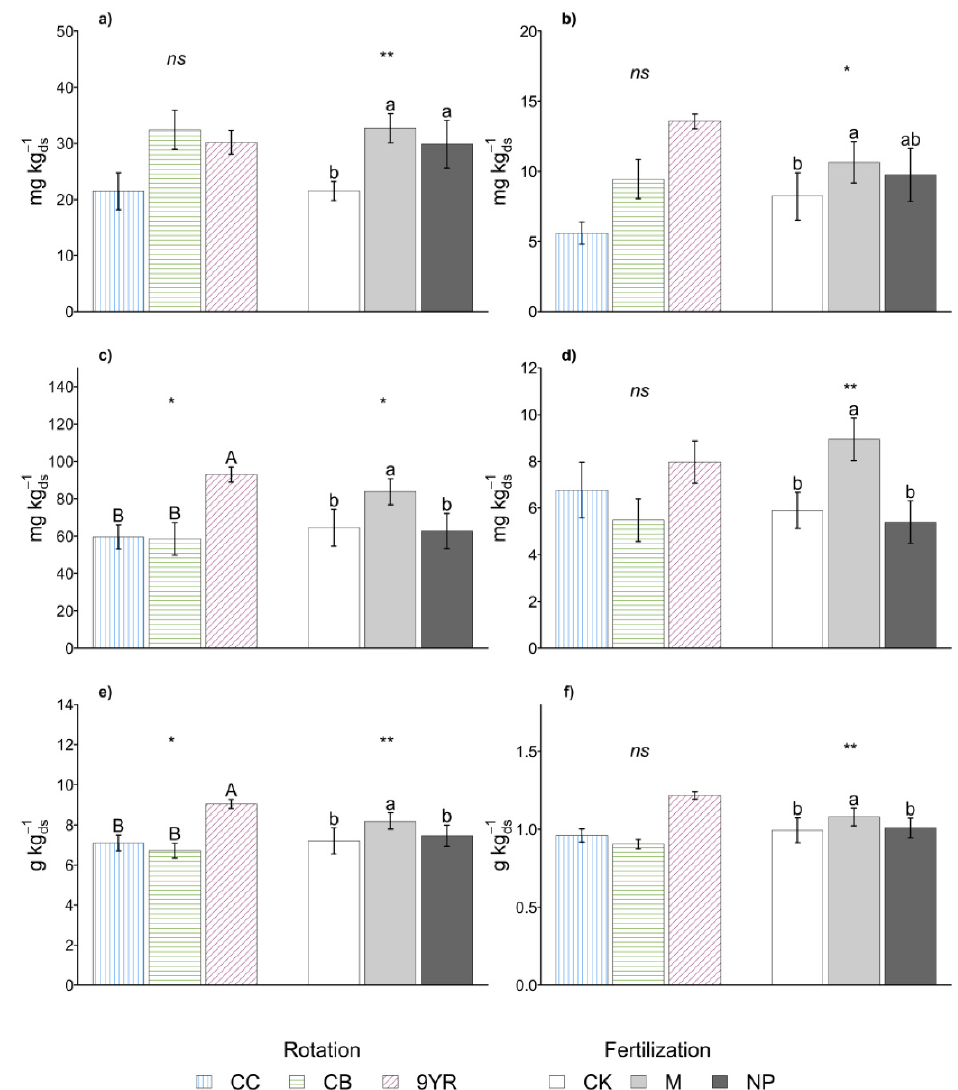
Figure 2. Marginal means of soil ( a ) extractable carbon, ( b ) extractable nitrogen, ( c ) microbial biomass carbon (MBC), ( d ) microbial biomass nitrogen (MBN), ( e ) organic carbon, ( f ) total nitrogen for crop rotation and fertilization effects. Error bars represent standard errors. Different upper-case and lower-case letters indicate significant differences ( p -value < 0.05), respectively, between rotation and between fertilization as determined by the Fisher’s least significant difference (LSD) test. Statistical significance of the differences according to the ANOVA ( ns p < 0.05; * p ≤ 0.05; ** p ≤ 0.01; *** p ≤ 0.001).